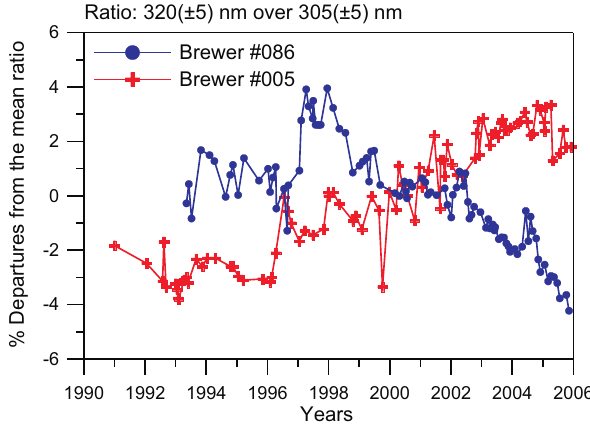
Fig. 3. The spectral variation of the calibration factors of Brewers #005 and #086, throughout the period of their operation, expressed by the ratio of the calibration factors at 320nm ( ± 5nm) and 305nm ( ±